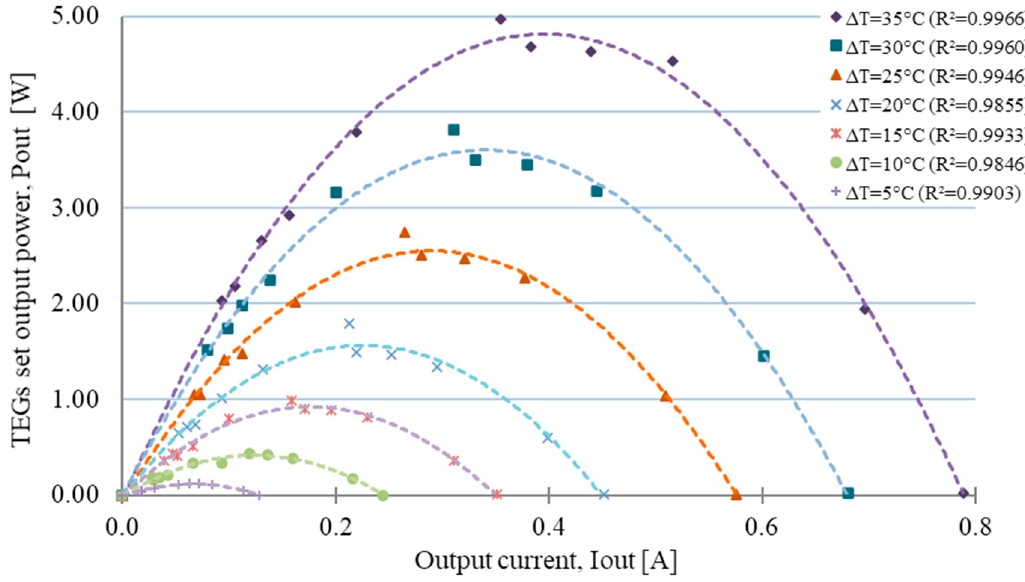
Figure 9. TEGs set output power as a function of current for various temperature differences.